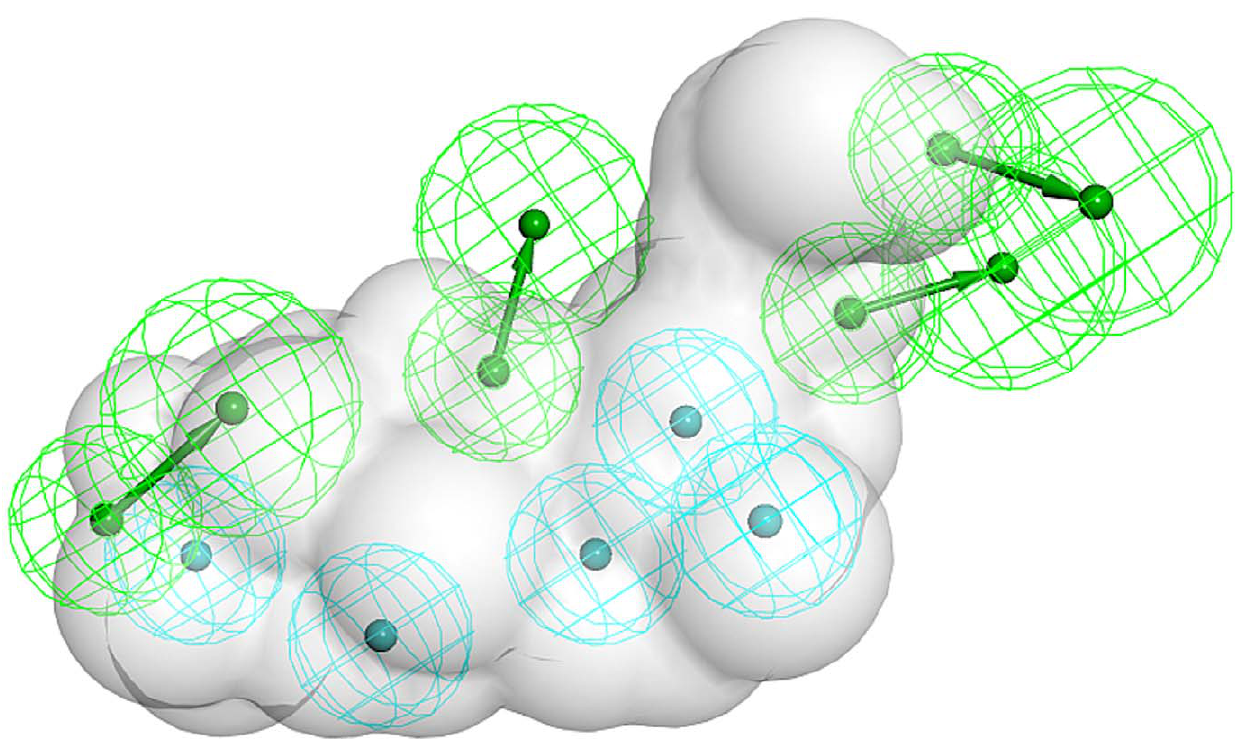
Figure 2. 11 b -HSD inhibitors pharmacophore model. The hydrogen bond acceptor features are represented in green, and the hydrophobic features in blue. The shape of carbenoxolone, as a steric constraint to prevent too large molecules from fitting, is shown as a grey volume.